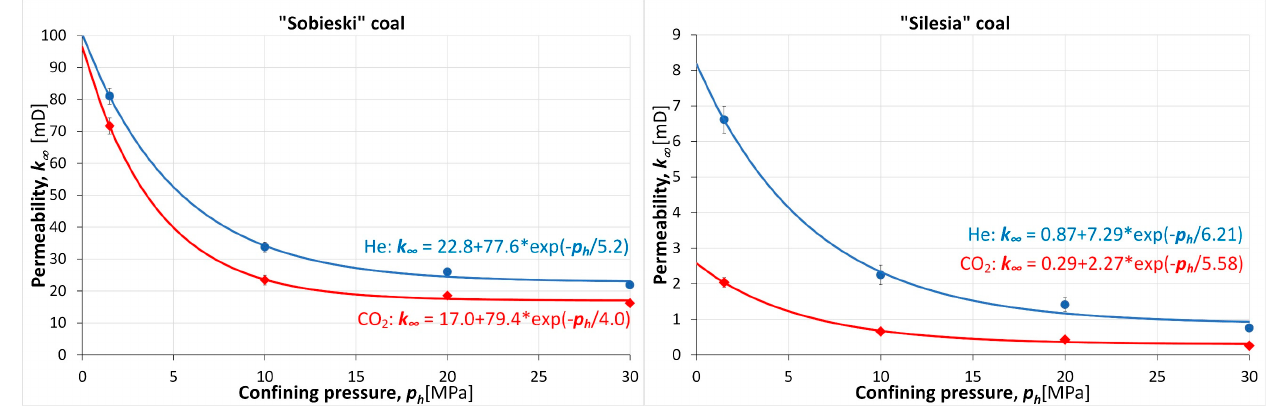
Figure 6. Dependence of coal permeability on confining pressure.